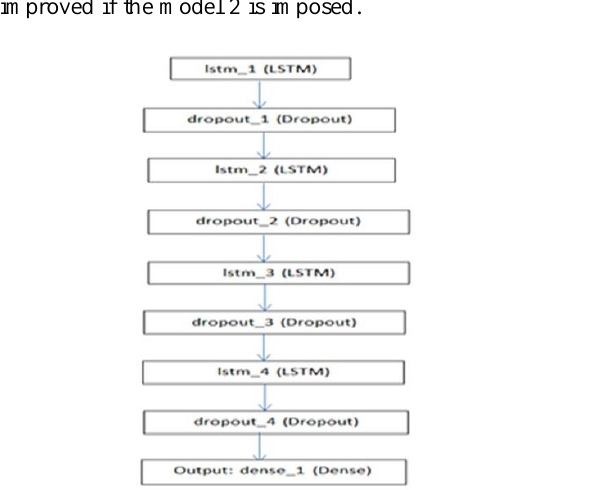
Figure 2: Neural network structure for model 1.